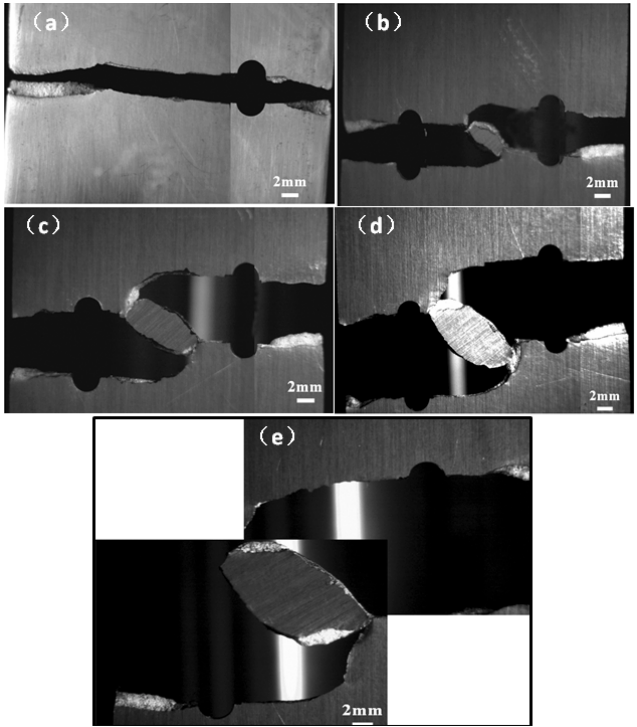
Figure 8. The fractured specimens for ( a ) A1 with a single crack, ( b ) specimen H2.3 (initial condition: crack offset H = 2.3 mm), ( c ) specimen H4.6 (initial condition: H = 4.6 mm), ( d ) specimen H6.9 (initial condition: H = 6.9 mm), ( e ) specimen H9.2 (initial condition: H = 9.2 mm).